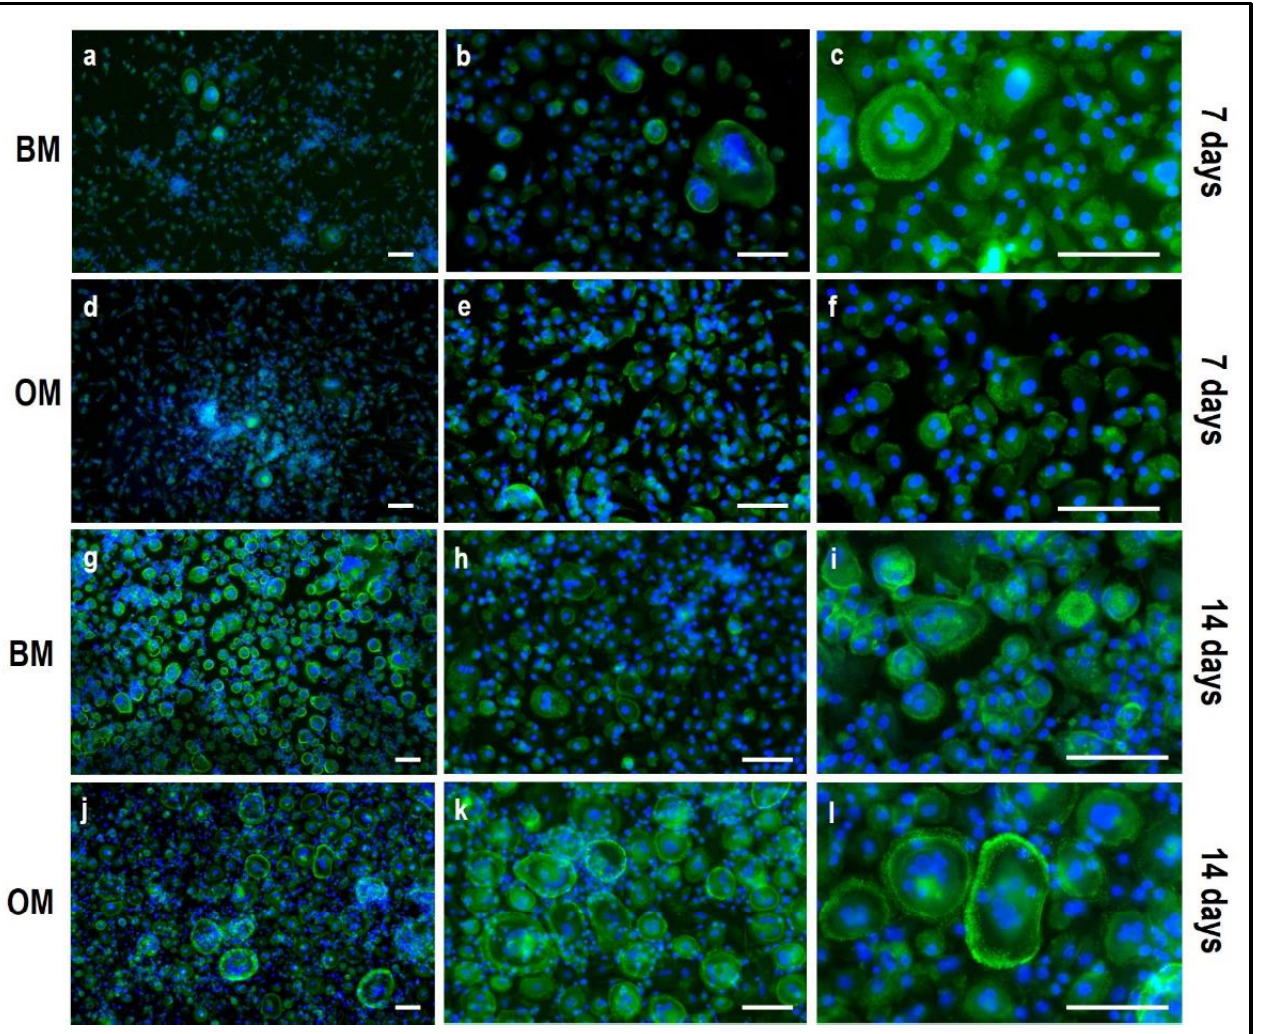
Figure 10. Microphotographs of PBMCs stained for multinuclearity (Hoechst dye, blue) and actin filaments/ring (Phalloidin-FITC, green) derived from the indirect co-culture in basal medium (BM) and osteogenic medium (OM) at 7 and 14 days. ( a – c ): basal medium at 7 days, ( d – f ): osteogenic medium at 7 days, ( g – i ): basal medium at 14 days, ( j – l ): osteogenic medium at 14 days. Scale bar: 100 µm.